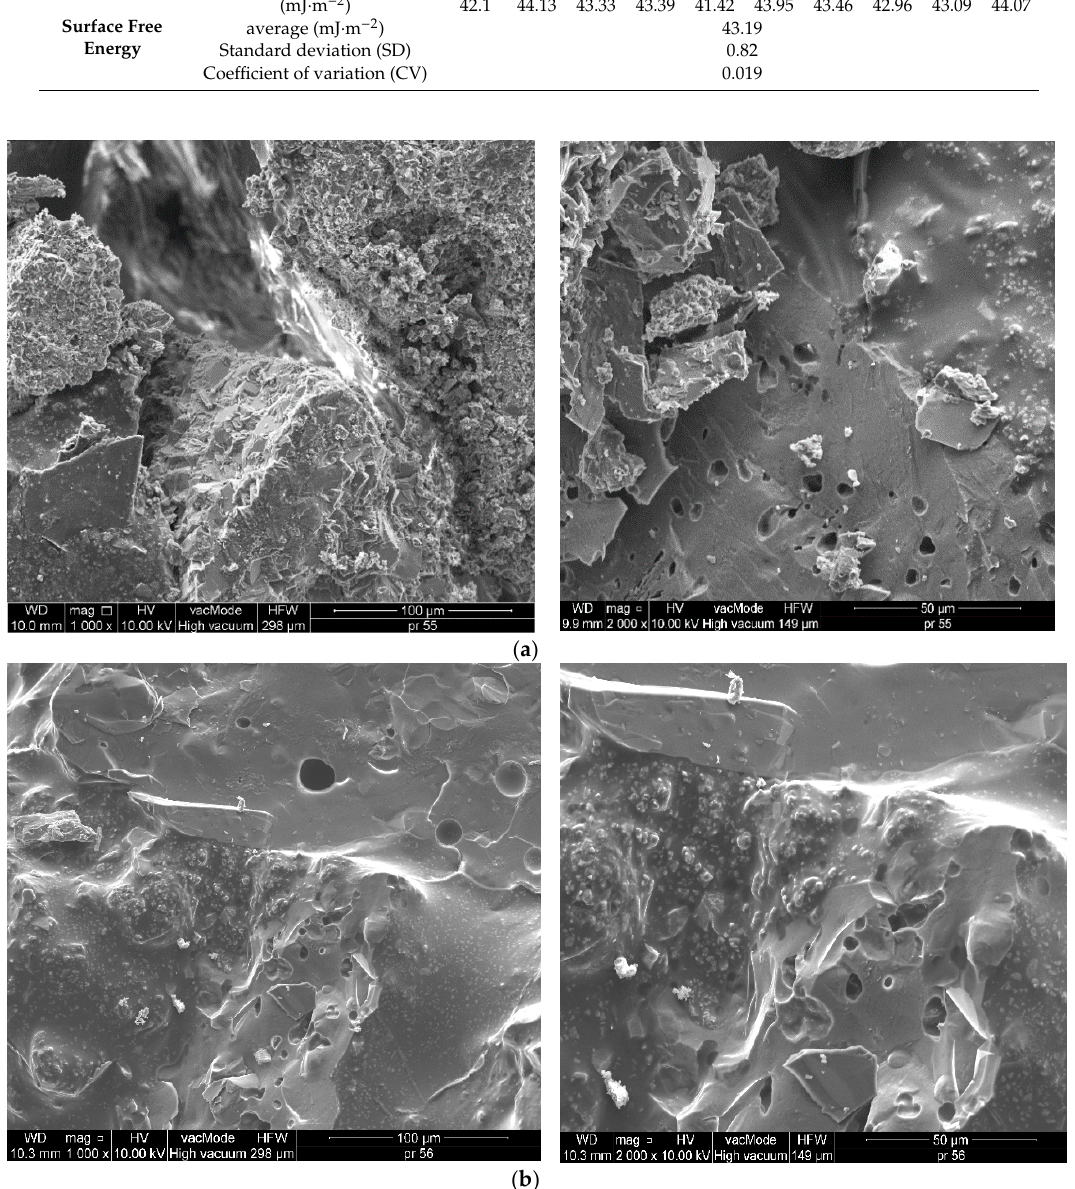
Figure 5. SEM microstructures of mineral–asphalt mixtures (1000× and 2000×): ( a ) WC-1; ( b ) WC-2.